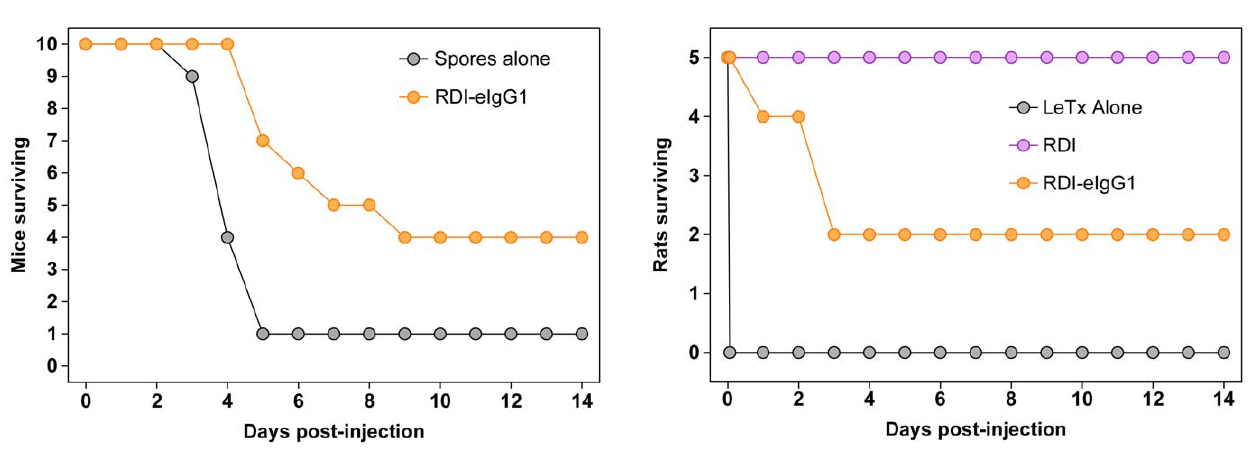
Table 1. Summary of studies measuring RDI-eIgG1 protection from LeTx challenge in rats.